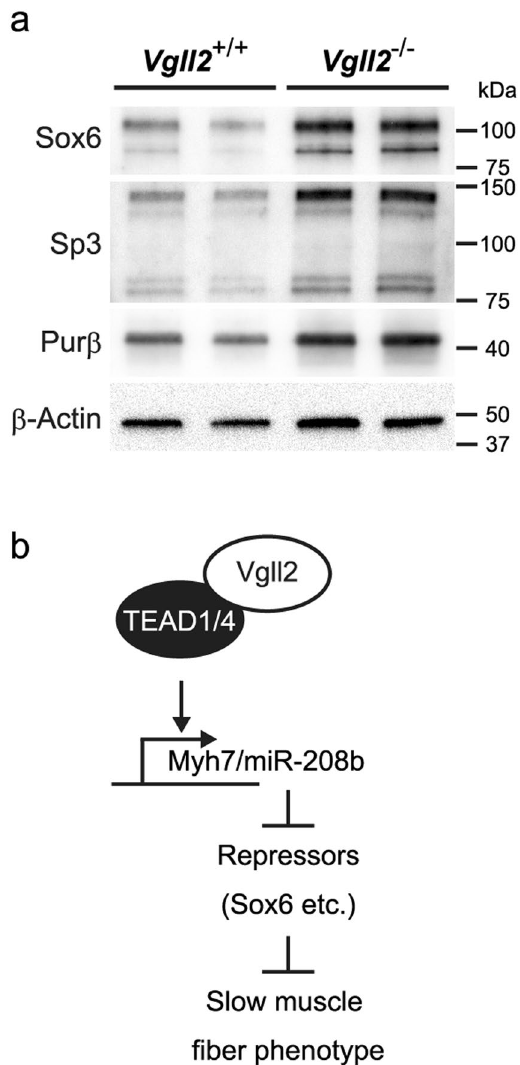
Figure 7. Expression analysis of transcriptional repressor proteins in the neonatal skeletal muscles. ( a ) Sox6, Sp3, and Pur β protein levels were assessed by Western blotting in the GPS muscle from Vgll2 + / + and Vgll2 − / − mice at P7. β -Actin was used as a loading control. Analyses were performed on four mice per genotype. Data from two mice per genotype are shown. Uncropped original images are shown in Supplementary information. ( b ) Schematic representation of the possible mechanism of TEAD1-mediated Vgll2 functions in muscle fiber type